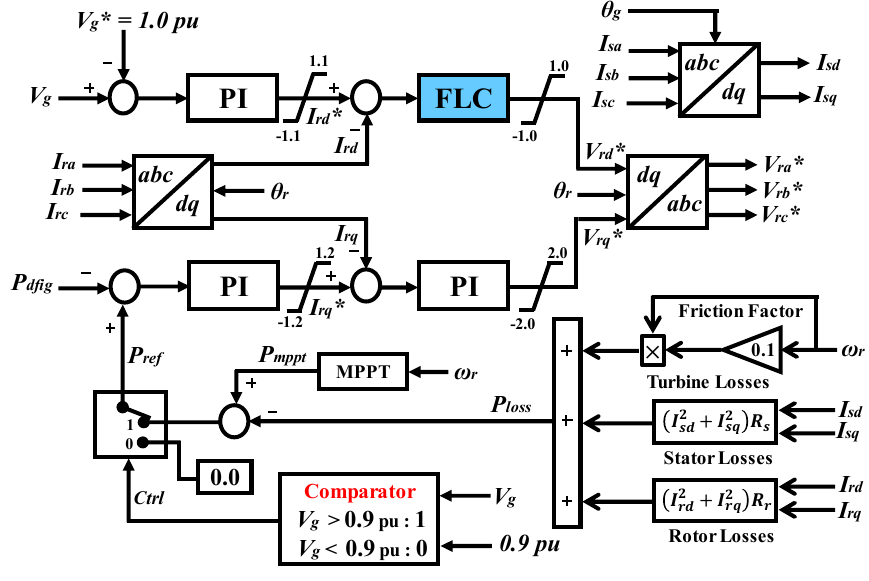
Figure 6. Proposed rotor ‐ side controller.